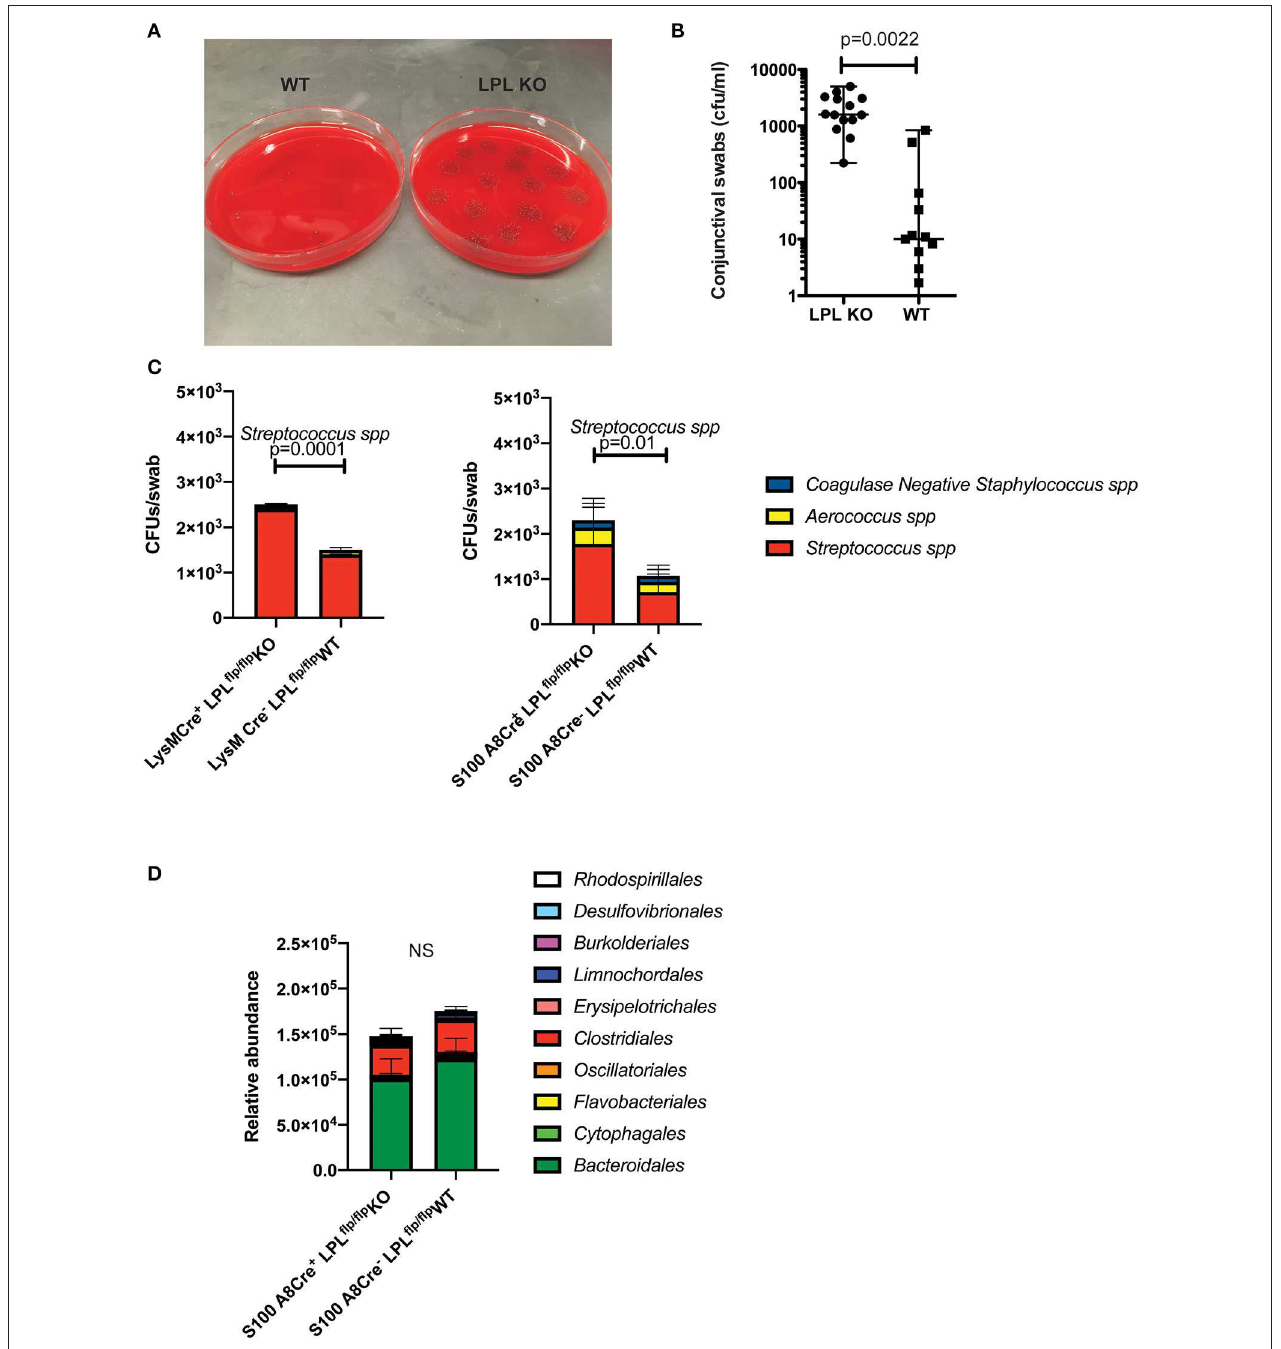
FIGURE 5 | LPL deficient mice show altered conjunctival commensal presence. (A) Conjunctival swabs were taken from cohorts of LPL KO ( n = 7) mice and LPL WT littermates ( n = 7) and commensal presence identified using LC-MS/MS and quantified by plating on blood agar plates. Representative blood agar plates from LPL WT and LPL KO mice. (B) Quantification of the commensal presence per swab. LPL KO mice showed elevated levels of Streptococcus spp. when compared to LPL WT mice. Each symbol represents an individual mouse (Mann-Whitney test, p = 0.002). (C) Conjunctival swabs were taken from cohorts of LysM.Cre pos ( n = 7) mice, WT littermates and S100A8.Cre pos ( n = 7) and commensal presence identified using LC-MS/MS and quantified by plating on blood agar plates. Commensal presence was monitored at 7 weeks of age. A statistically significant elevation was detected when the levels of the Streptococcus spp. were compared (Two-way ANOVA, p = 0.0001 and 0.01, respectively). Experiments were repeated twice with representative data shown. (D) Gut commensal abundance was evaluated via 16S metagenomics analysis. Fecal samples were collected from S100A8.Cre pos ( n = 7) and WT ( n = 7) littermates, genomic DNA extracted, microbial abundance evaluated (Two-way ANOVA). No significant changes were observed at the order levels. Cumulatively, data demonstrates commensal overgrowth in the absence of L-plastin, a phenotype that appears specific to the ocular niche.